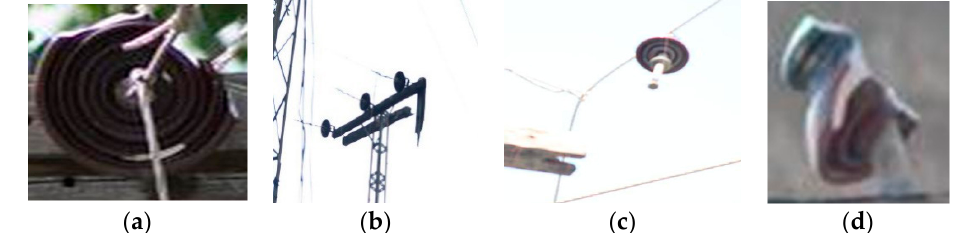
Figure 5. Different faults found in power distribution systems: ( a ) broken suspension disc insulator, ( b ) broken cross arm, ( c ) unclipped pin insulator from the cross arm, ( d ) broken pin insulator.